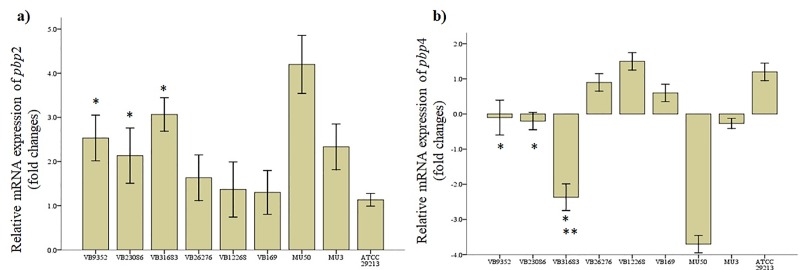
Quantitative transcription of pbp2 and pbp4 genes among TR-MRSA strains (n = 6).Data are indicated as mean and standard deviation. Error bar represents the standard deviation of three mean values. Upregulation of pbp2 and downregulation of pbp4 were significant in VB9352, VB23686, and VB31683 compared to S. aureus ATCC 29213 (marked with a single asterisk, p < 0.01). VB31683 showed significant pbp4 downregulation compared to the MU3 strain (marked with a double asterisk, p < 0.01). Expression levels of pbp2 were comparable to that of the MU3 strain.